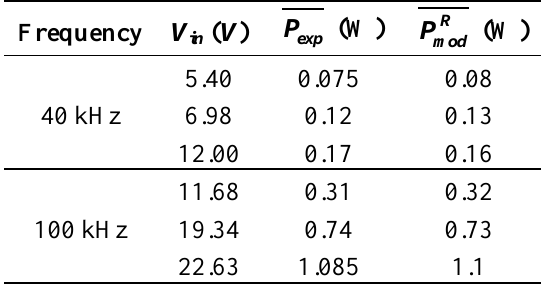
Table 2. Experimental and modeled average powers for three different values of input voltage of the converter ( V in